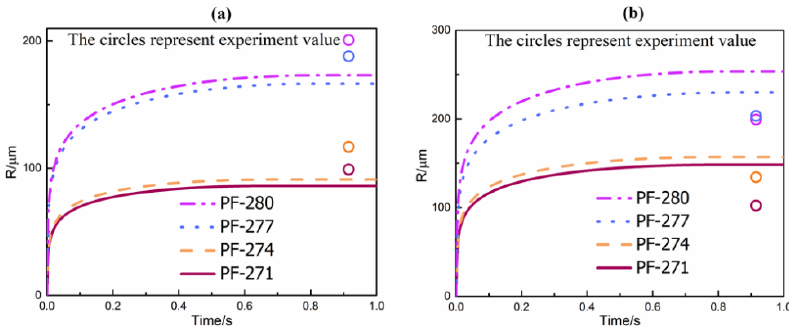
Figure 13. Simulated bubble growth of PET scCO 2 extrusion foaming: ( a ) low shear region; ( b ) high shear region.